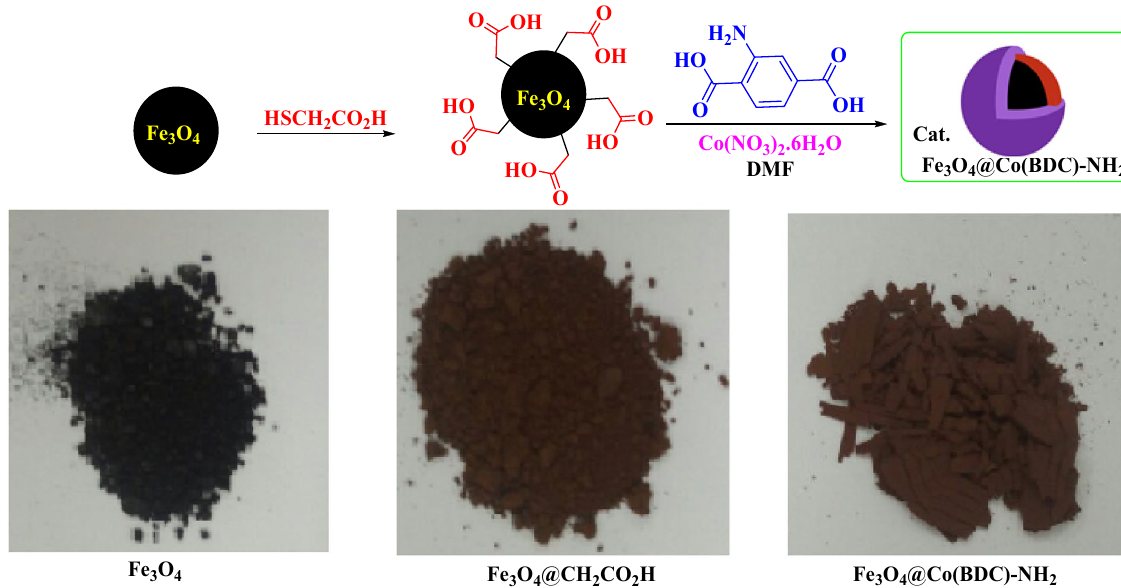
Figure 2. Stepwise synthesis of the nanomagnetic metal–organic frameworks (NMMOFs)